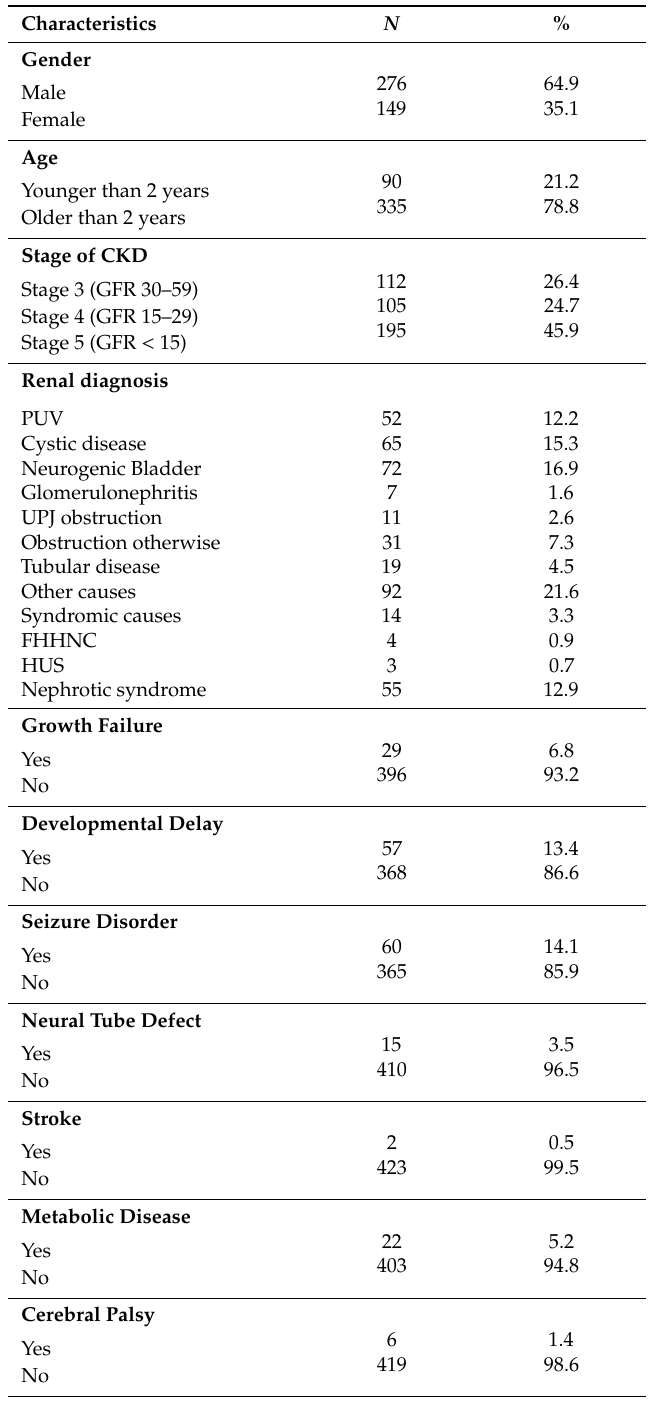
Table 1. General descriptive studies of all variables ( n =